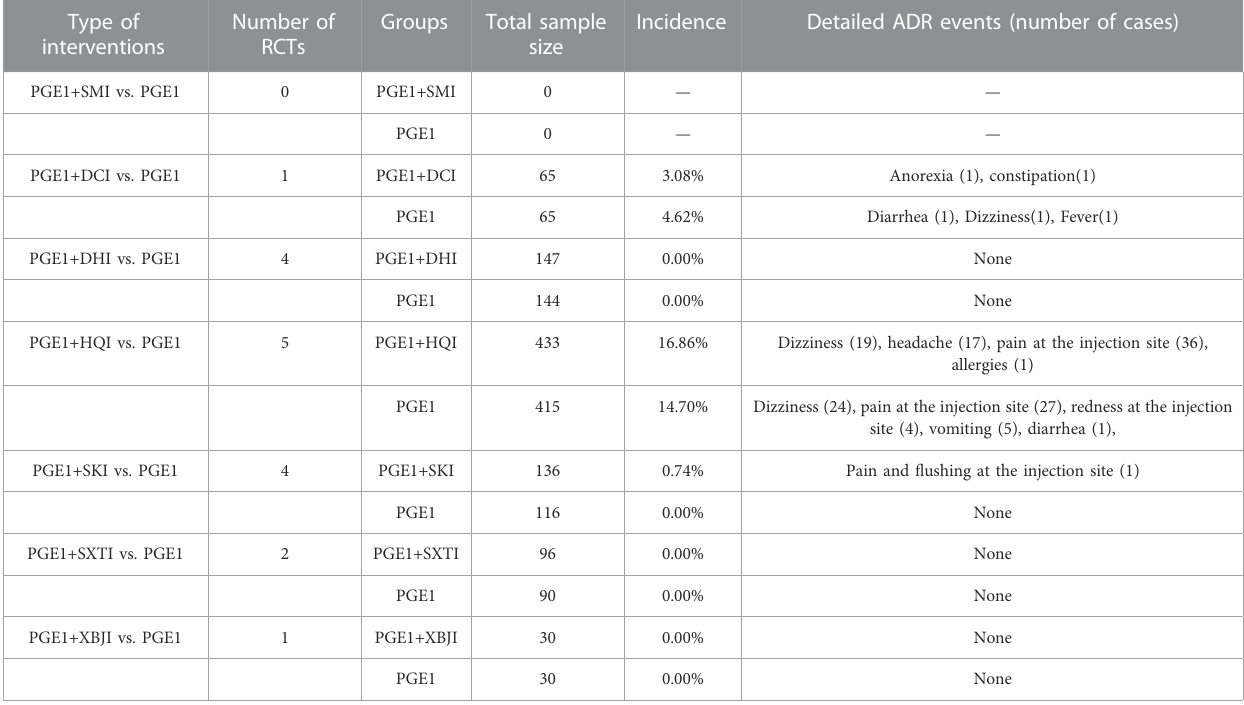
TABLE 6 Summary of adverse drug events.